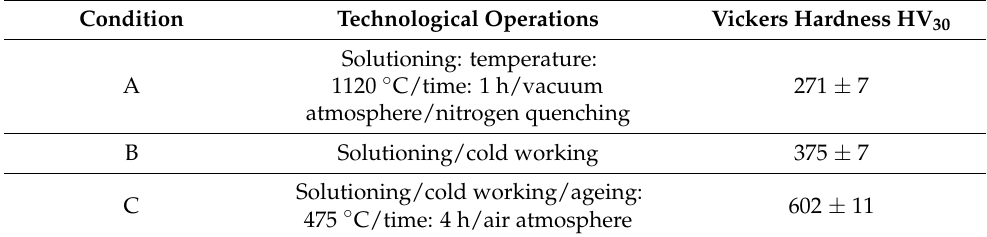
Table 2. Nanoflex steel conditions and corresponding Vickers hardness. Condition Technological